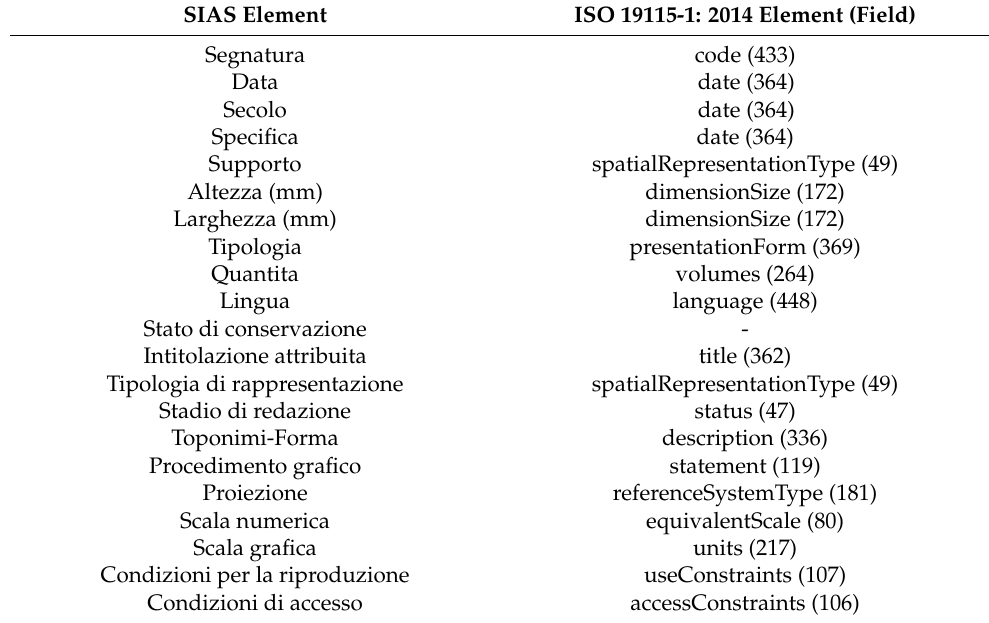
Table 3. Semantic mapping between SIAS and ISO 19115-1: 2014